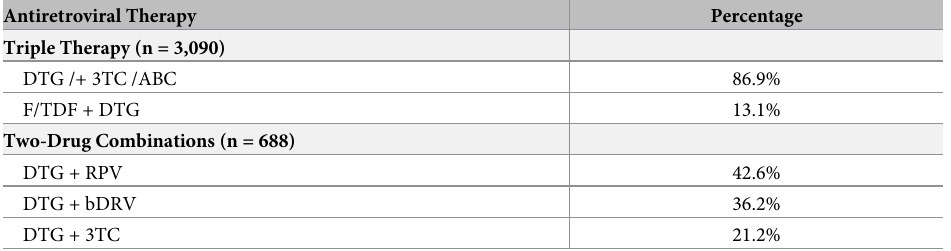
Table 5. Antiretroviral therapy distribution within dolutegravir containing therapy sub-sample, by treatment